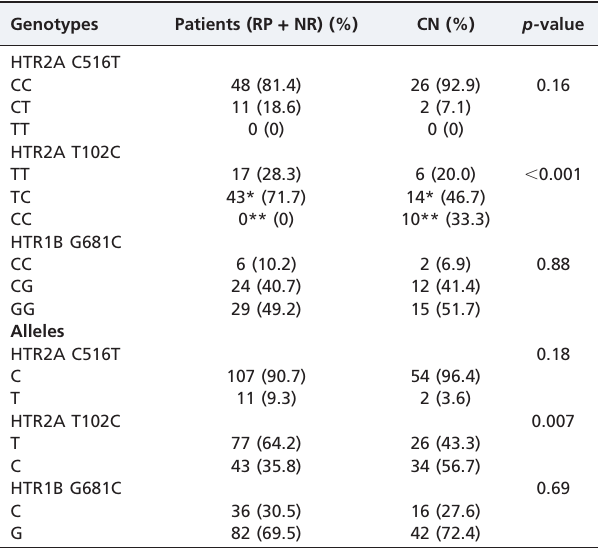
Table 1 - Polymorphism frequency among patients and controls.